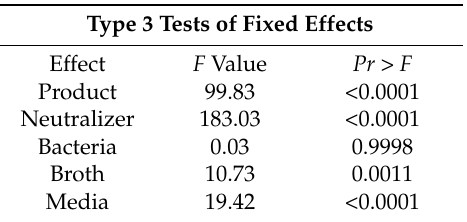
Table 4. Factors influencing the growth of Bacillus